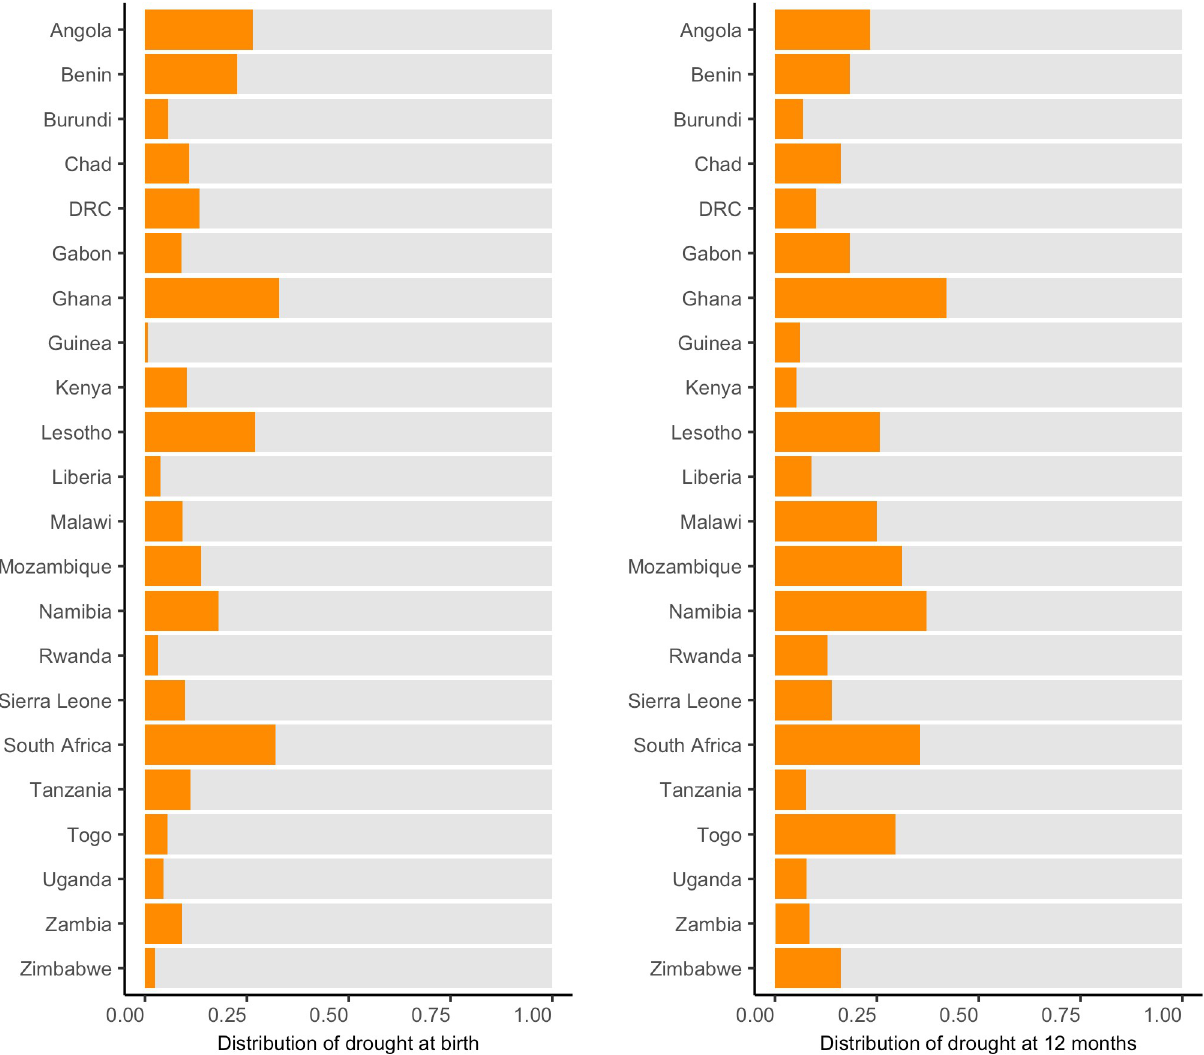
Fig 1. Distribution of drought at birth and 12 months age. The proportions of observations in drought are represented by orange bars. DRC, Democratic Republic of the Congo. https://doi.org/10.1371/journal.pmed.1003678.g001 Lesotho) demonstrated negative associations between drought at birth and 3 doses of DPT vaccination, 4 countries (Chad, Uganda, Lesotho, and Benin) demonstrated negative associa- tions between drought at birth and 3 doses of polio vaccination, and 4 countries (Rwanda, Democratic Republic of the Congo, Ghana, and Malawi) demonstrated negative associations between drought at 12 months and measles vaccination. These country-level analyses also yielded instances when drought was positively associated with vaccination. In Zambia and Kenya, drought was positively associated with BCG vaccination. In Gabon and Burundi, drought was positively associated with DPT vaccination. In Malawi and Ghana, drought was positively associated with polio vaccination. Finally, in Kenya, drought was positively associ- ated with measles vaccination. Due to this heterogeneity, we also specified models using mixed effects regression (with random intercepts at the survey and EA levels). Findings were qualita- tively consistent (in magnitude and direction) across specifications (S4 Table).